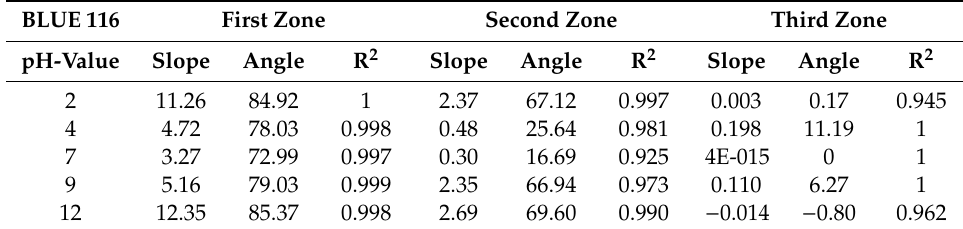
Table 1. Return of Weber and Morris models for Reactive Blue 116.